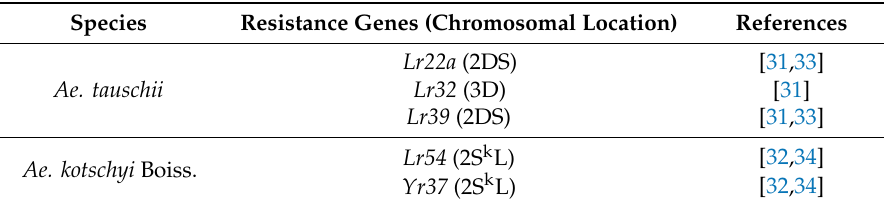
Table 1. Leaf and stripe rust resistance genes transferred from Aegilops species into triticale genome through distant hybridization followed by